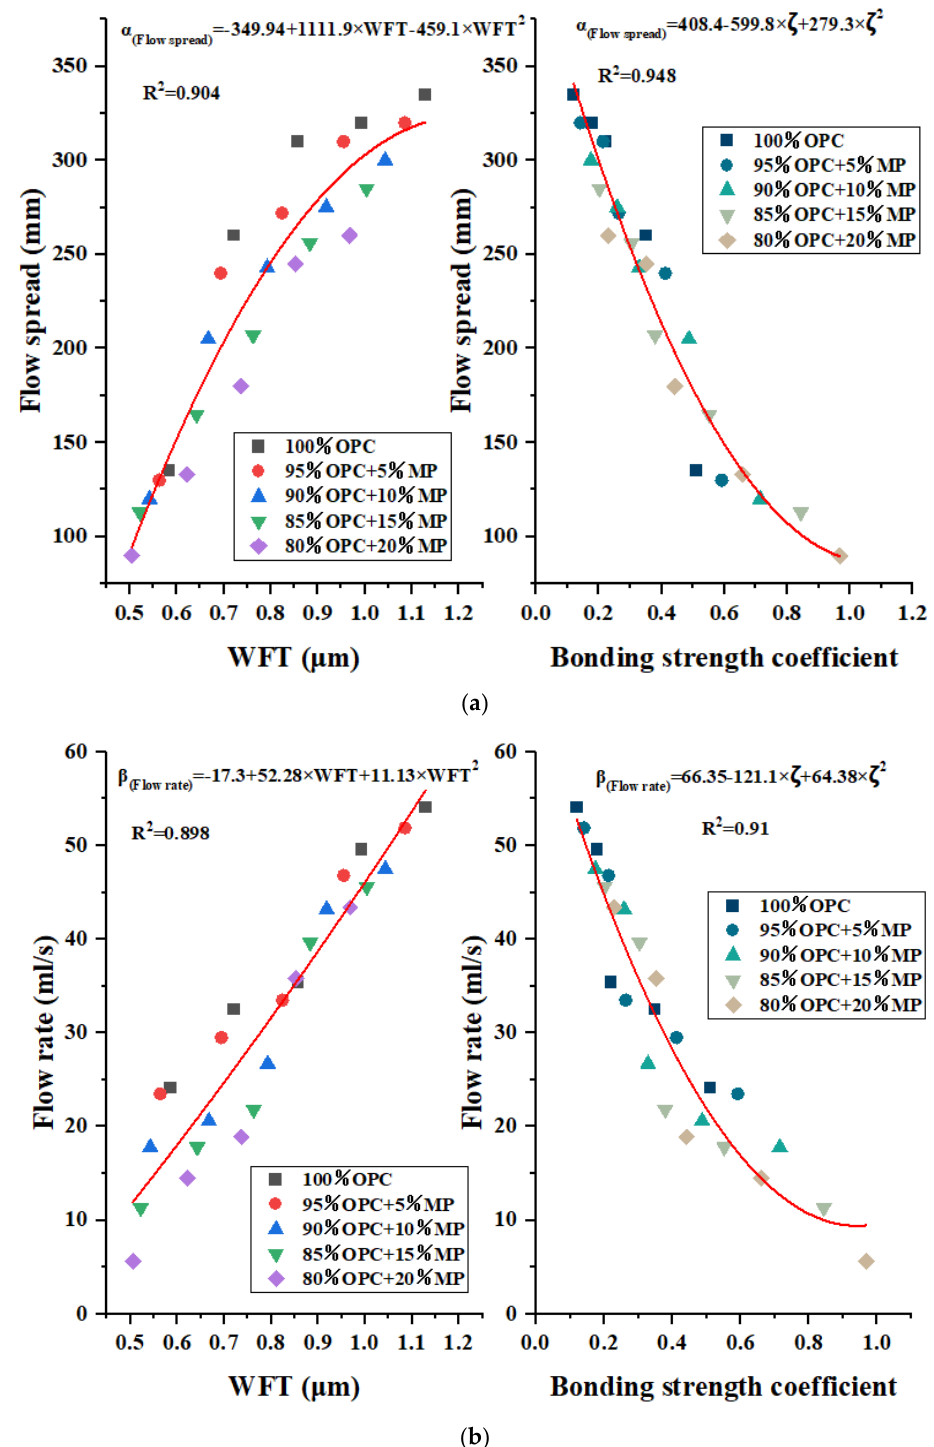
Figure 13. Flow spread and flow rate versus WFT and the bonding strength coefficient. ( a ) Flow spread. ( b ) Flow rate.